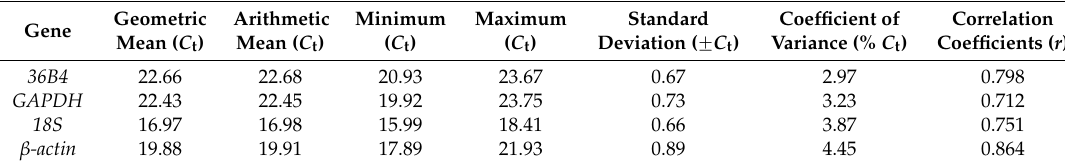
Table 3. Expression stability of four reference gene in inguinal beige adipose tissues (iBeAT) evaluated by BestKeeper ( n = 12).